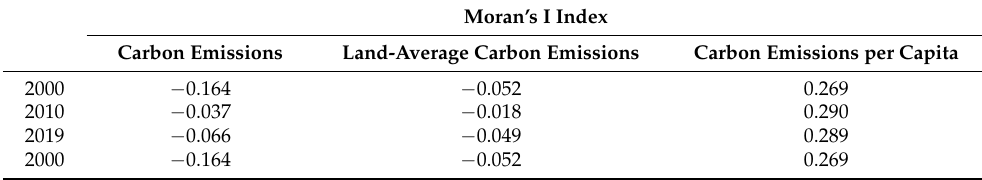
Table 3. Global Moran’s I index of carbon emissions of Shandong Peninsula urban